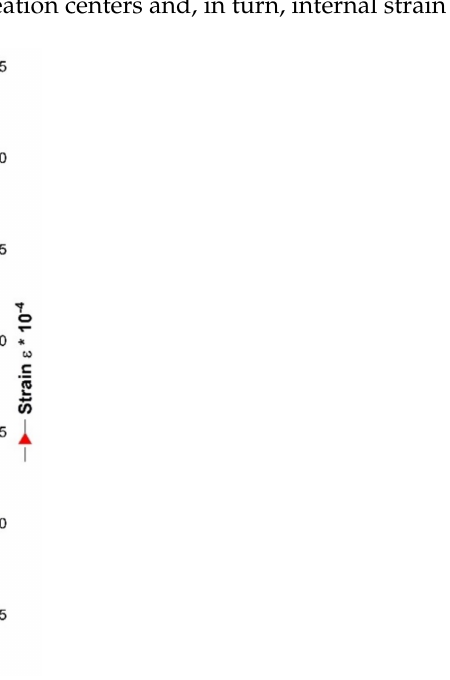
Figure 3. Crystallite size and strain of TiO 2 -SiO 2 thin films based on the quantity of dip-coating